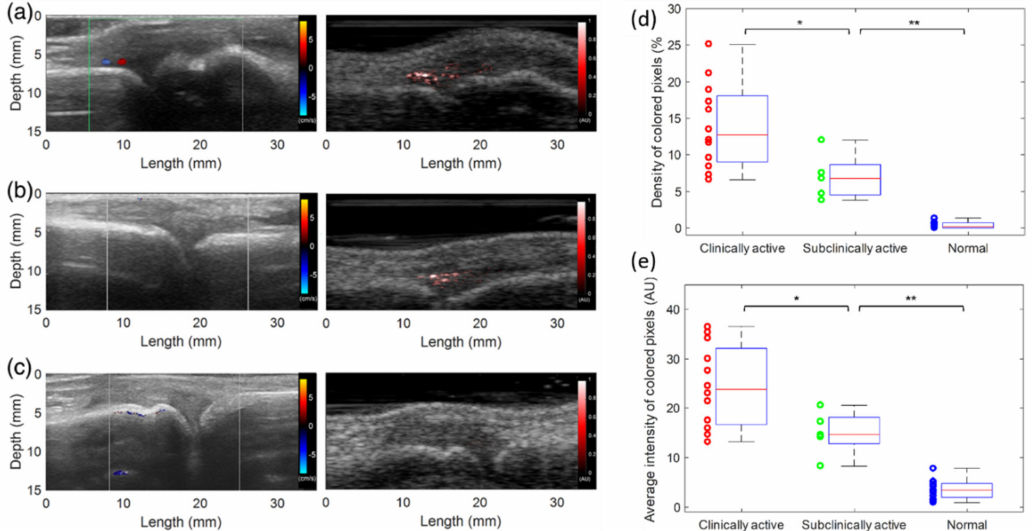
Figure 14. US Doppler (left) and PA (right) images acquired from LED-based system from three groups: ( a ) clinically active arthritis joints, ( b ) subclinical active arthritis joints, and ( c ) normal healthy joints). ( d ) The quantified results showing the density of colored pixels and ( e ) the average intensity of colored pixels in PA images of the three groups. * p < 0.05, ** p < 0.005. Reprinted from Ref. [31].